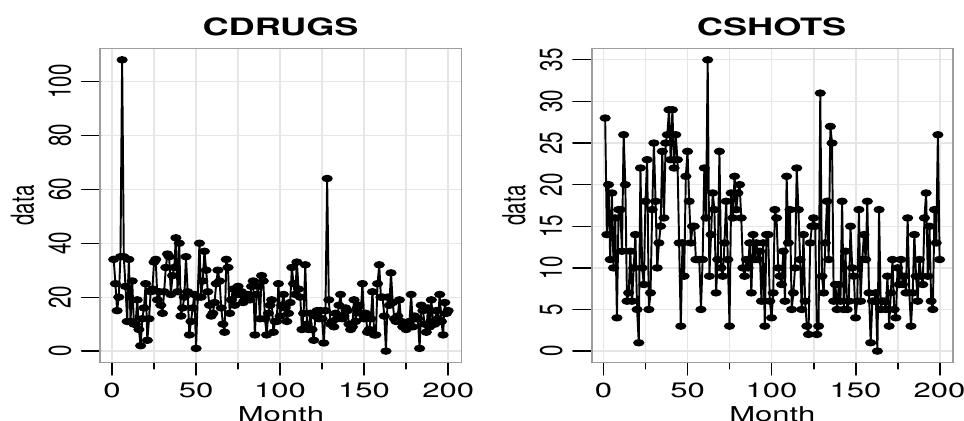
Figure 1. The time-series plot of CDRUGS and CSHOTS data.